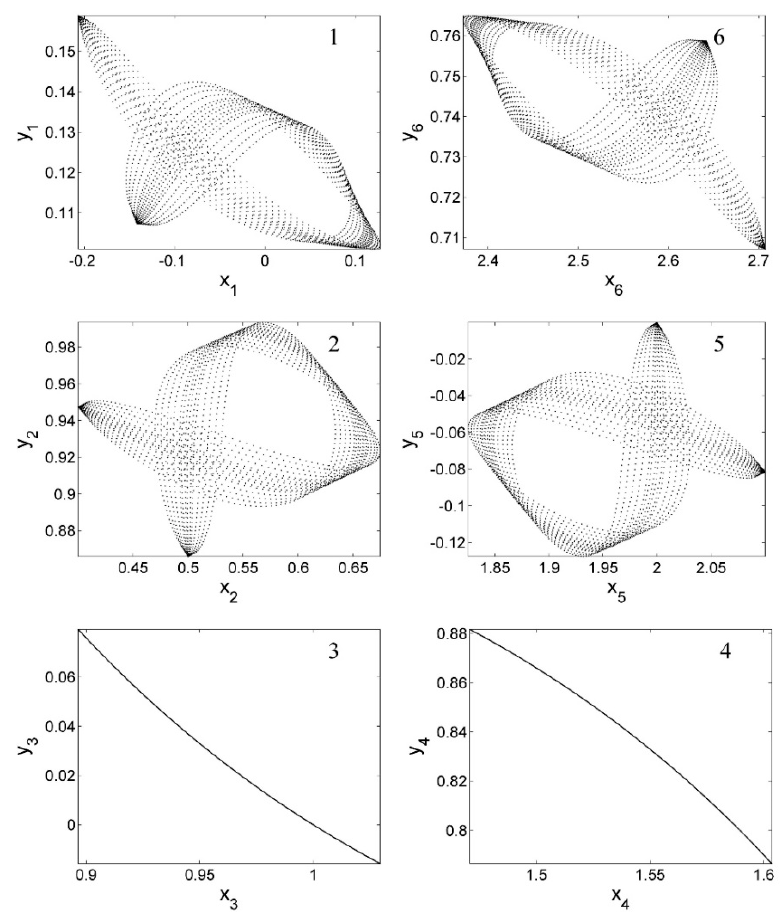
Figure 10. The trajectory of the six balls of the LGG algorithm during the time 300 ∼ 400 s with m = 2 and η = 0.1 .